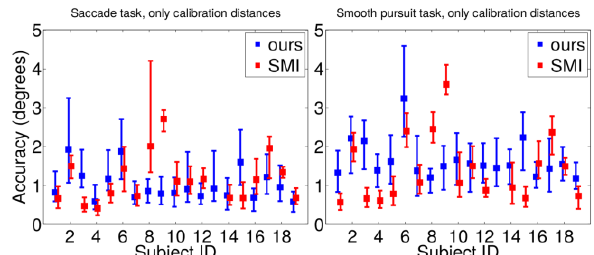
Figure 15. Accuracy values for the saccade task (left panel) and the smooth pursuit task (right panel) for the presented and SMI systems, using only data from the cal- ibration distances. See caption of Figure 14 for details